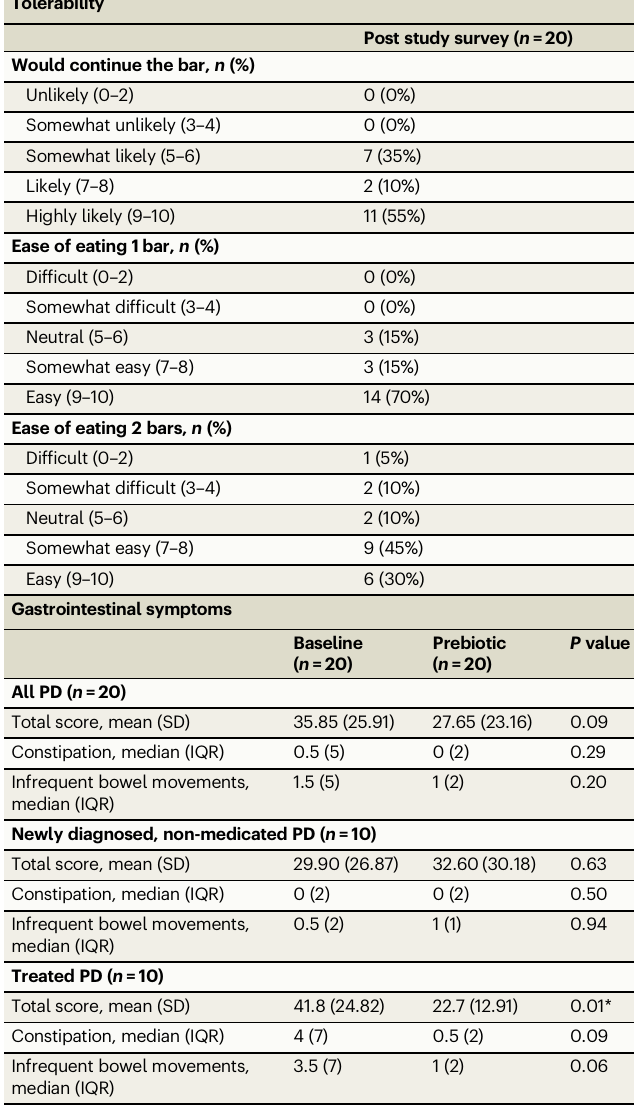
Table 1 | Tolerability and gastrointestinal symptoms before and after the prebiotic intervention